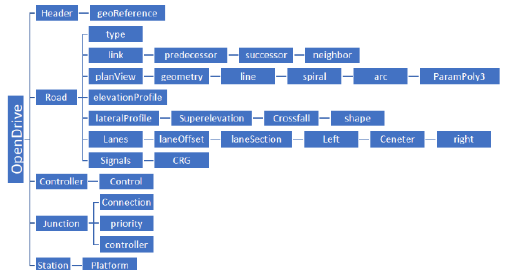
Figure 1. The structure of OpenDRIVE format (Barsi et al.,